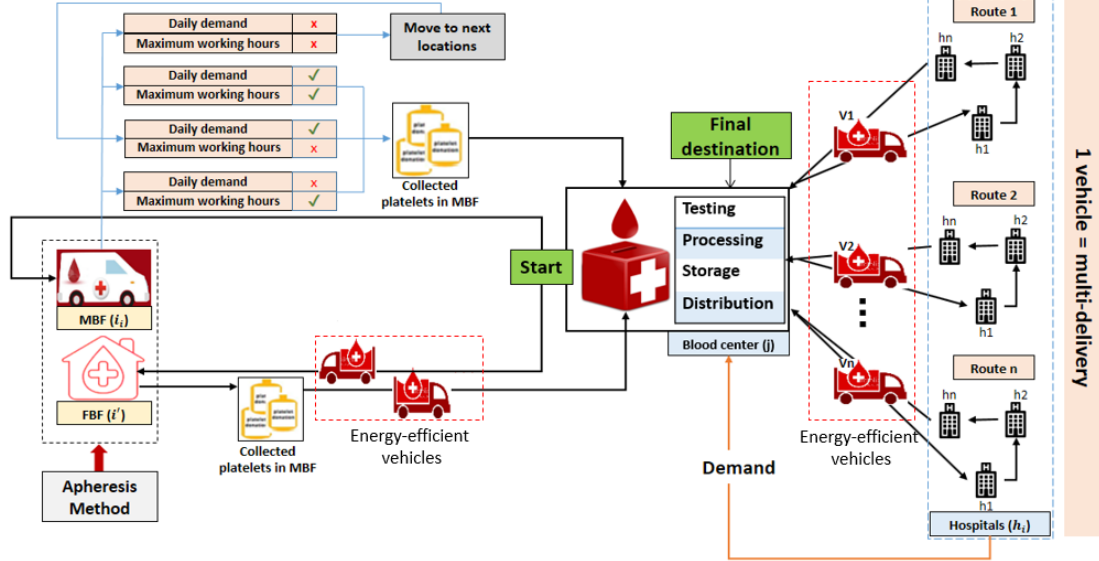
Figure 2. Flow diagram of healthcare supply chain management with optimal energy